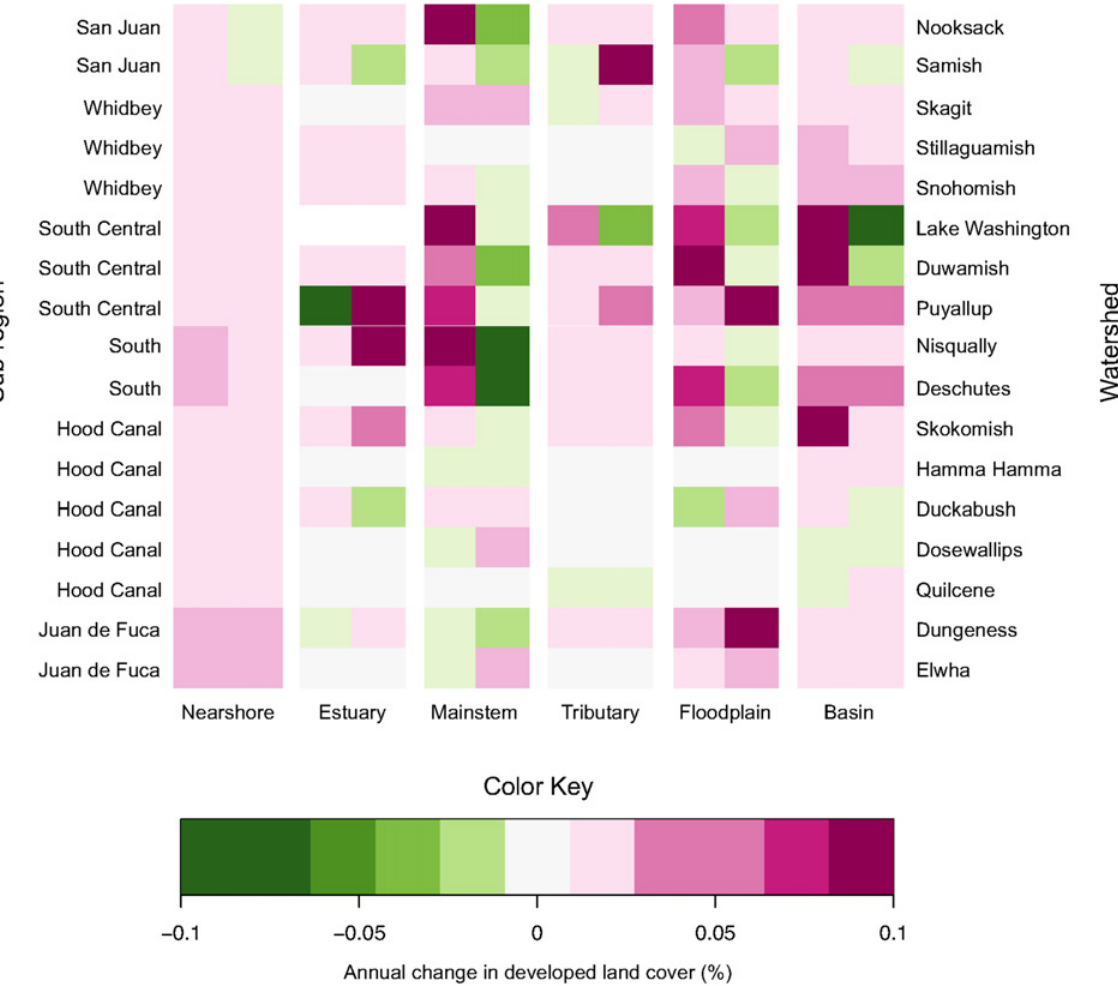
Fig 6. Changing Trends in Developed Land Cover: Watershed Scale. Heat map illustrating trends in developed land cover (regression slopes), summarized at the watershed scale for six habitat areas. Warmer colors indicate increasingly positive slopes; cooler colors increasingly negative slopes. A change in cell color between the first and second cell within a habitat-by-watershed combination indicates a substantially better fit of the segmented regression, compared to the simple regression (i.e., Δ AICc > 4), hence b 1 and b 2 are shown. If Δ AICc was < 4, both cells depict b 0 for the simple regression, unless the b 0 p -value exceeded 0.05, in which case both cells were assigned b 0 = 0. Note that the North Central sub-region has no corresponding watershed and, therefore, was omitted (but see S2